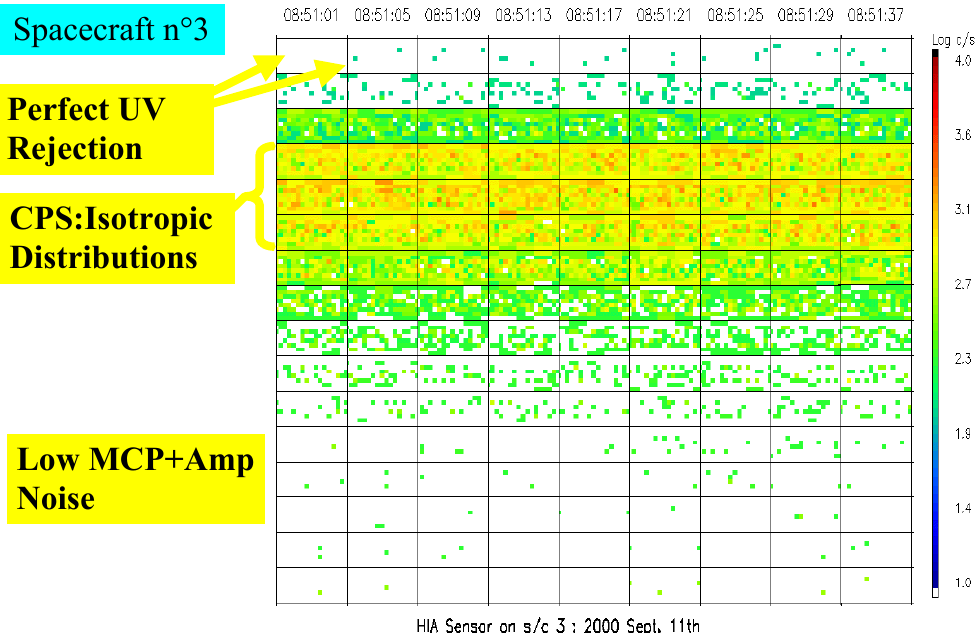
Fig. 8. Example of in-flight measurements of HIA on spacecraft 3 in the central plasma sheet on 11 September 2000. Each rectangle is a 2 – 8 plot, 2 , in ordinate, ranging from − 90 ◦ to + 90 ,8 , in abscissa, ranging from 180 ◦ to + 180 ◦ , with the sunward direction at ( 2,8 ) = (0 ◦ , ± 180 ◦ ). Each line corresponds to 1 of the 16 logarithmically spaced energies between 24.3eV (bottom line) to 34117.3eV. Ten successive measurements are shown (one by column). There is no Sun effect in the detector.